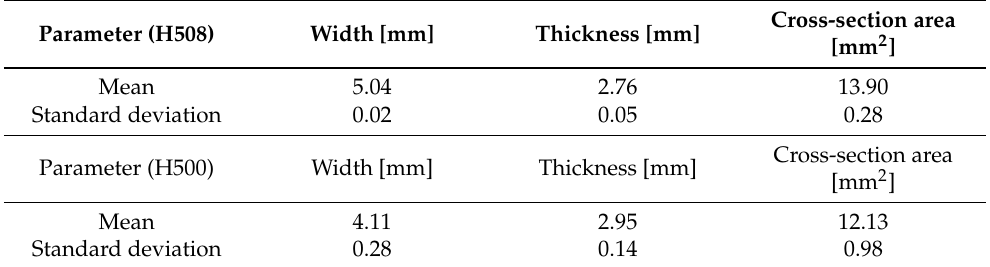
Figure 1. Specimens used in tensile and creep tests: ( a ) prior to testing, ( b ) after testing. Table 2. Geometry of